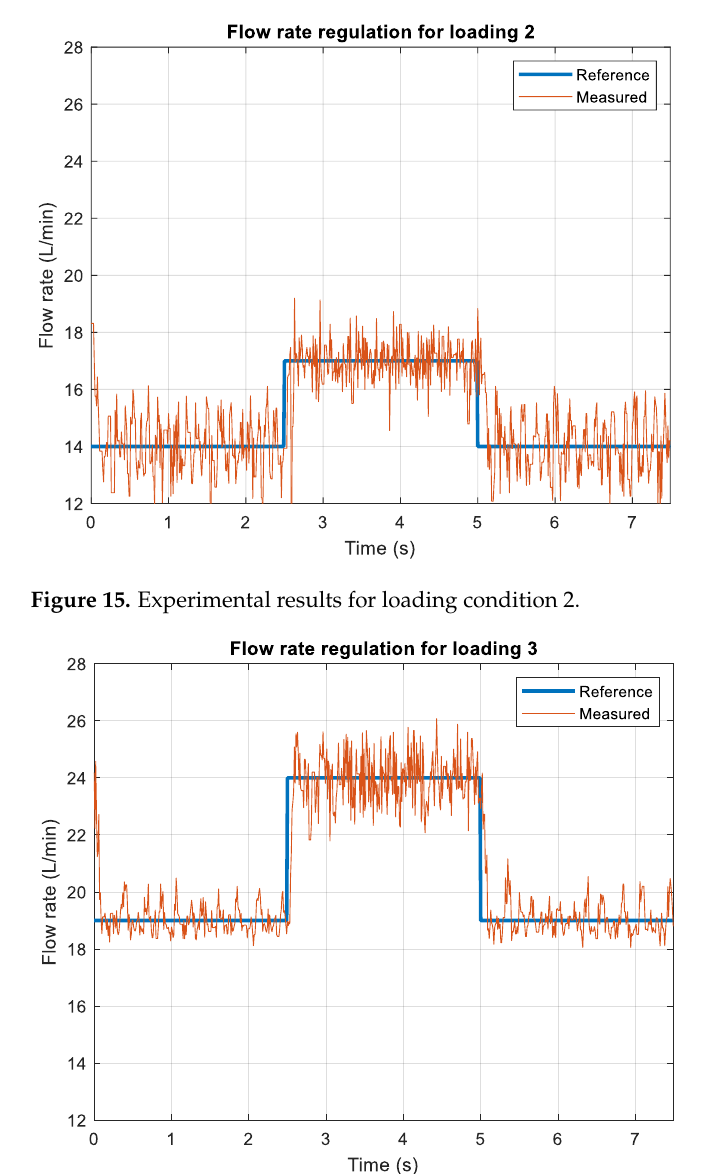
Figure 17. Experimental results for loading condition 4.